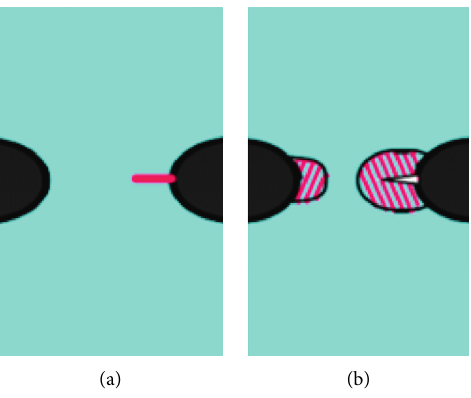
Figure 1: (a) High-cyclic fatigue and (b) low-cyclic